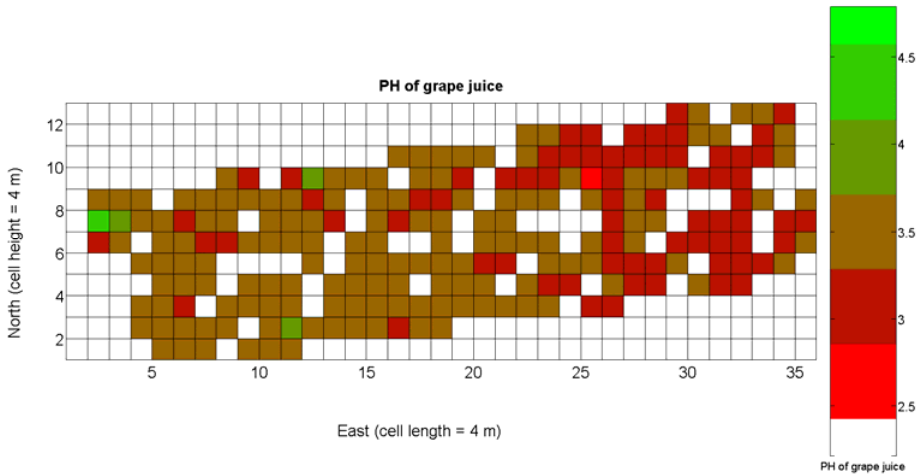
Figure 11. CB map of must pH.